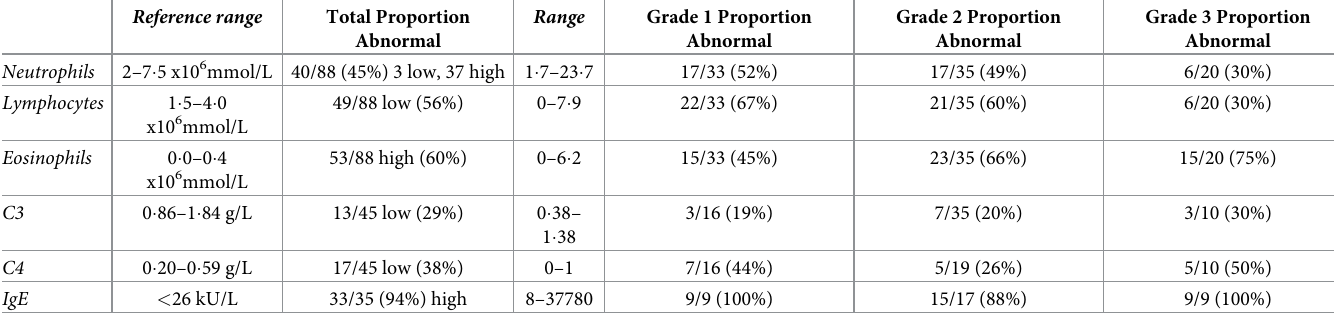
discharge against medical advice over a 5-month period and did not have a negative scraping until day 103 after initial presentation. Fifty-one episodes completed therapy as hospital inpa- tients and 22 had planned discharges with support to complete therapy as an outpatient after commencing therapy in hospital. The majority of the remaining 19 episodes were self-dis- charges without confirmed completion of treatment. In addition to the 10 patients who had recurrences during the 2-year study period, a further 8 had a first recurrence in the 22-month follow up period, making a total 18 (22.5%) of the 80 patients who had 1 or more repeat presentations with confirmed recurrent crusted scabies. Age at recurrence ranged from 5–79 years. They were all Indigenous, 9 were diabetic, 1 was on dialysis, 5 had hazardous alcohol intake and 1 had HTLV-1 infection. Overall, 8 patients had a single recurrence, 6 had two, 3 had three and 1 had four recurrences. The time interval between episodes is shown in Table 6. Of the total of 33 recurrences, 1 was within 1 month of